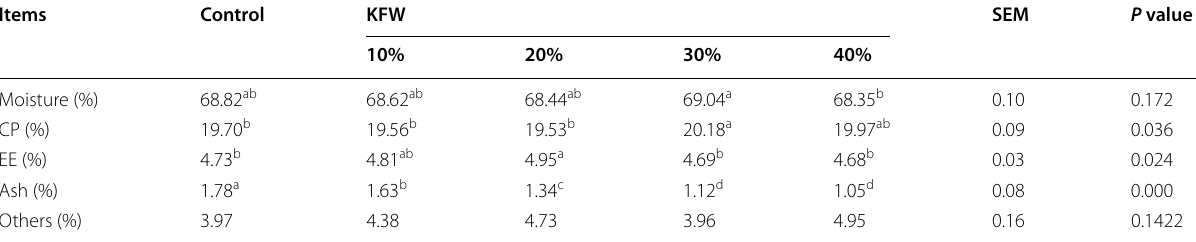
a,b,c Means with different superscripts in the same row differ significantly ( P < 0.05)